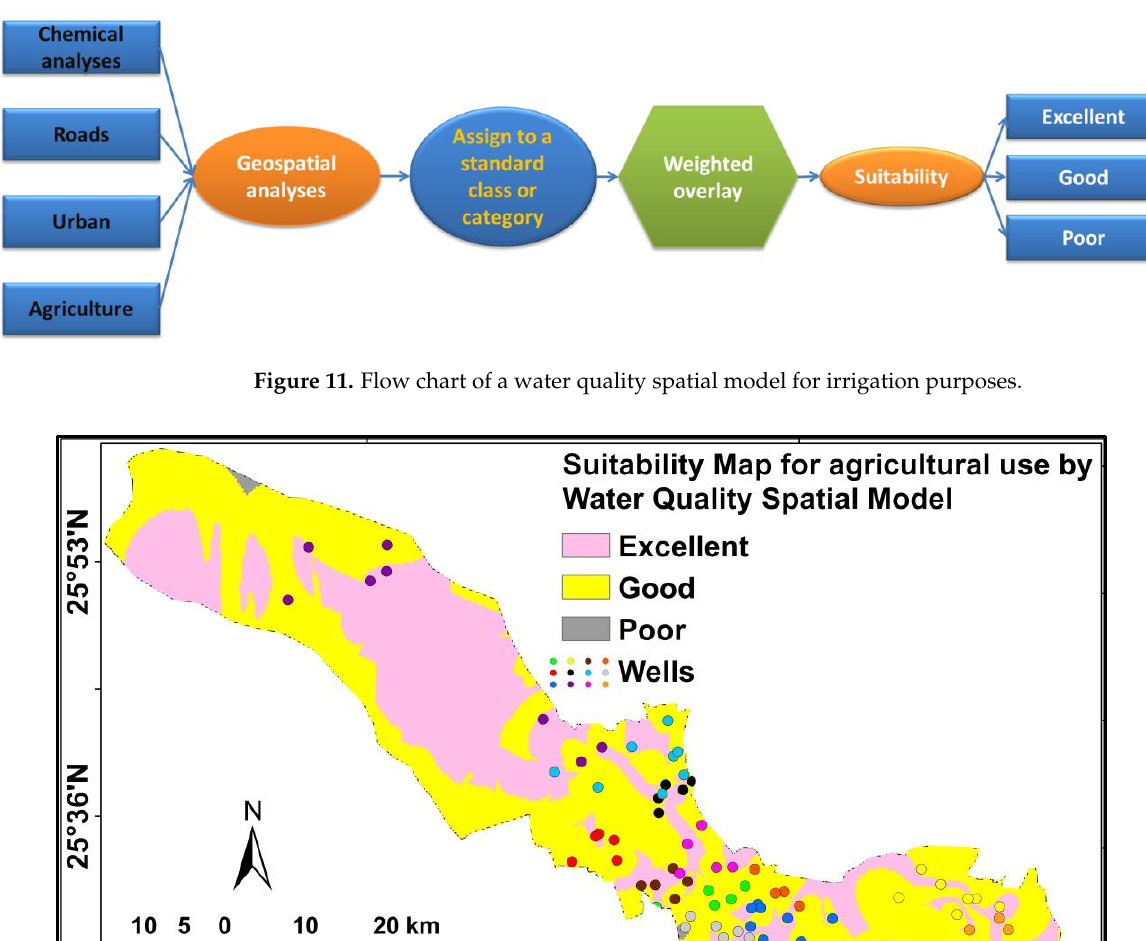
Figure 12. Suitability map for agricultural use by a water quality spatial model.